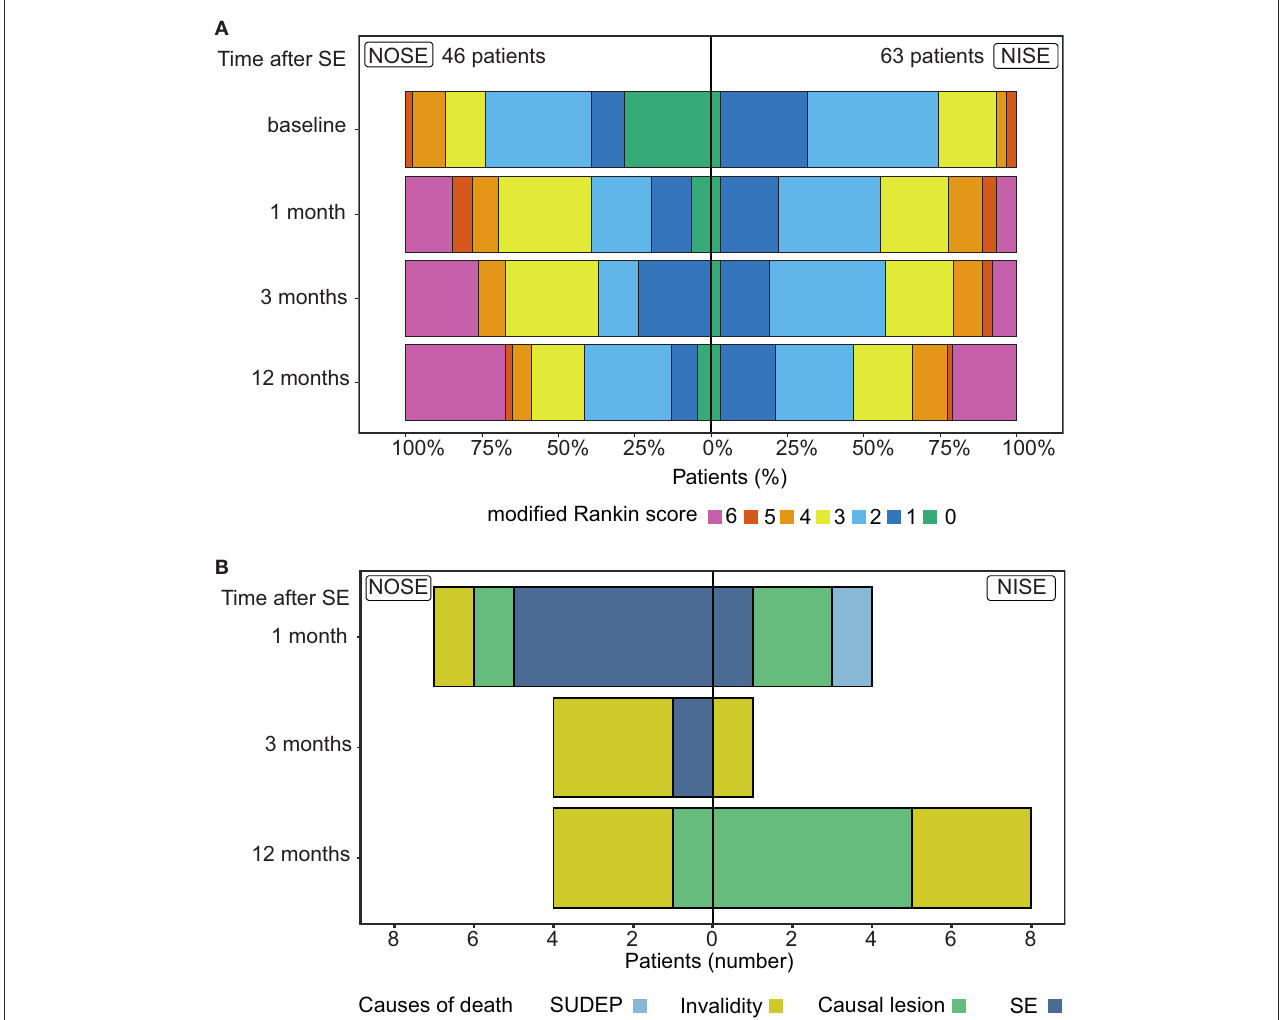
FIGURE3 Outcome and causes of mortality in NOSE and NISE. (A) Outcome (mRS) changes in each group at each time point. Proportions of patients in NOSE and NISE groups for each mRS value. (B) Causes of mortality at each time point in NOSE and NISE